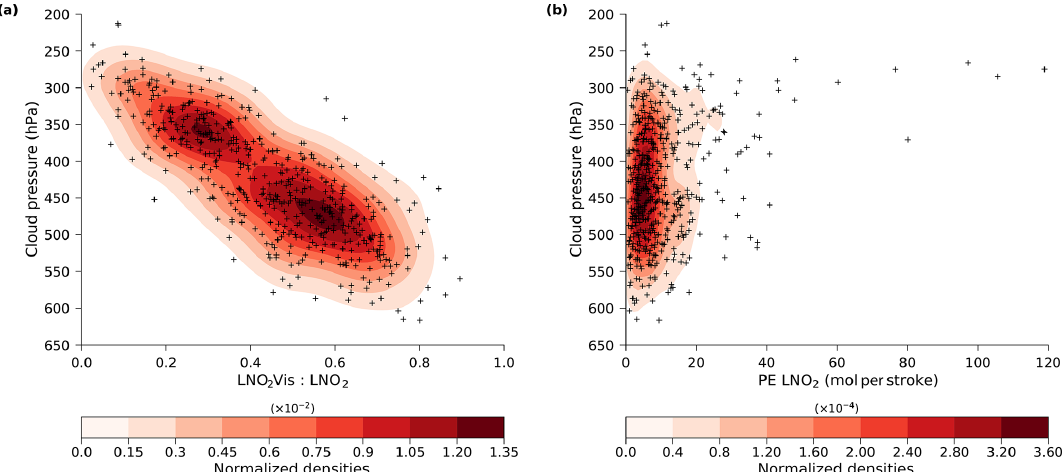
Figure 8. Kernel density estimation of the (a) daily ratio of LNO 2 Vis to LNO 2 and (b) daily LNO 2 production efficiency versus the daily cloud pressure measured by OMI with CRF ≥ 90% for MJJA 2014. The kernel density estimation was generated by kdeplot in the Python package named